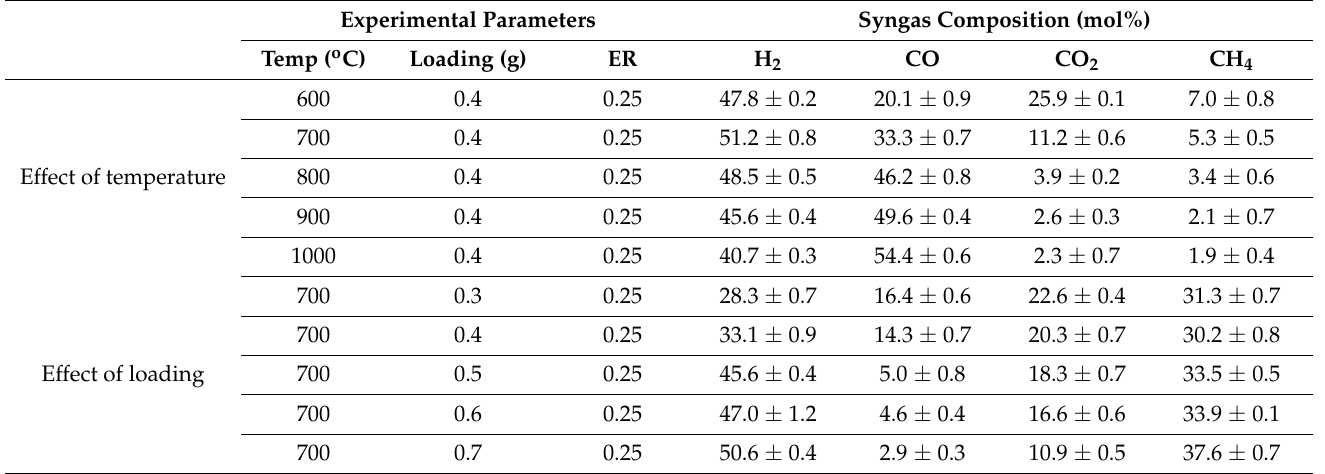
Table 5. Effect of temperature and loading in gasification for LEA and seaweeds. Results presented are average values from 2